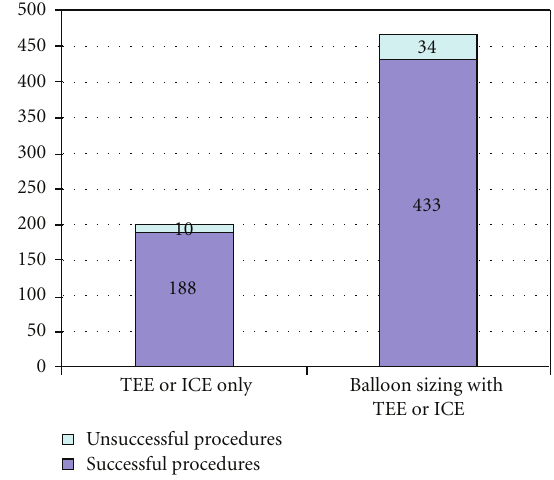
Figure 3: Failure ratios for patients who did, or did not, undergo balloon sizing ( n = 665). P value = 0.29, 95% CI of odd ratio =